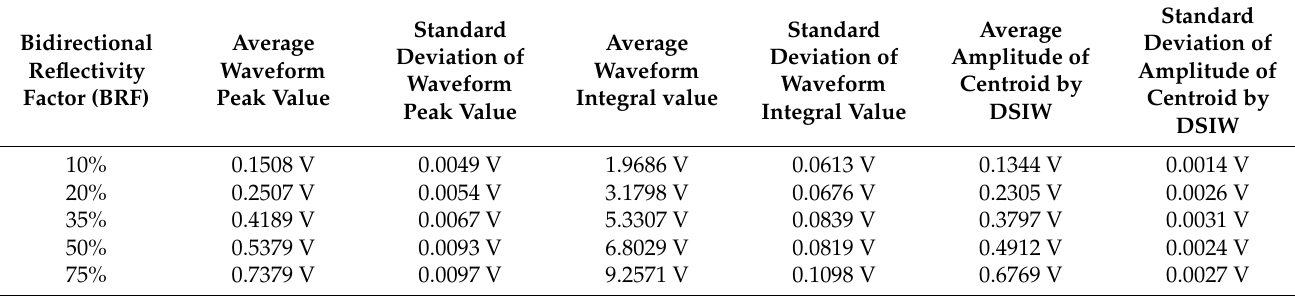
Table 4. Average intensity data and standard deviation of each method with added Gaussian white noise of 42.5